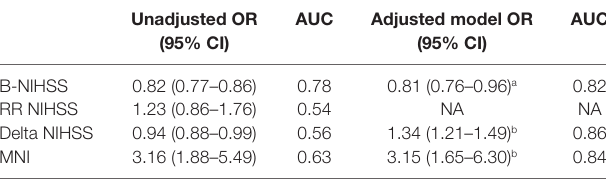
TaBle 2 | Logistic regression analysis for GFO in overall stroke cohort ( n = 369).